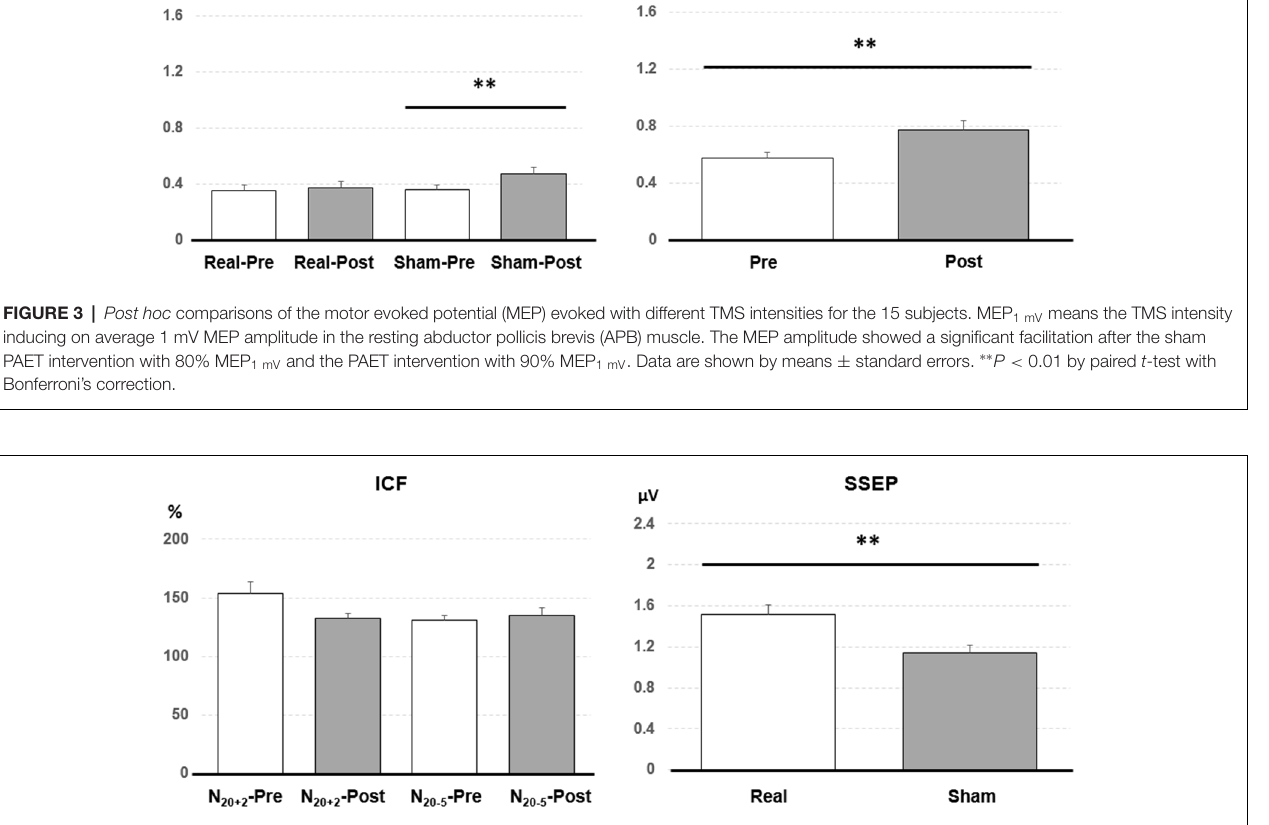
FIGURE 4 | Post hoc comparisons of the intracortical facilitation (ICF) and somatosensory evoked potential (SSEP). The ICF comparisons did not show any significant difference. The SSEP amplitude of the real condition was significantly higher than that of the sham condition. Data are shown by means ± standard errors. ∗∗ P < 0.01 by paired t -test with Bonferroni’s